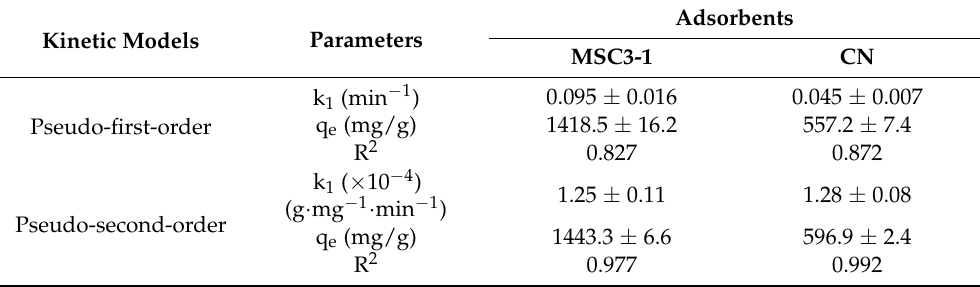
Table 3. Kinetic parameters of MCS3-1 and CN adsorption of MB.